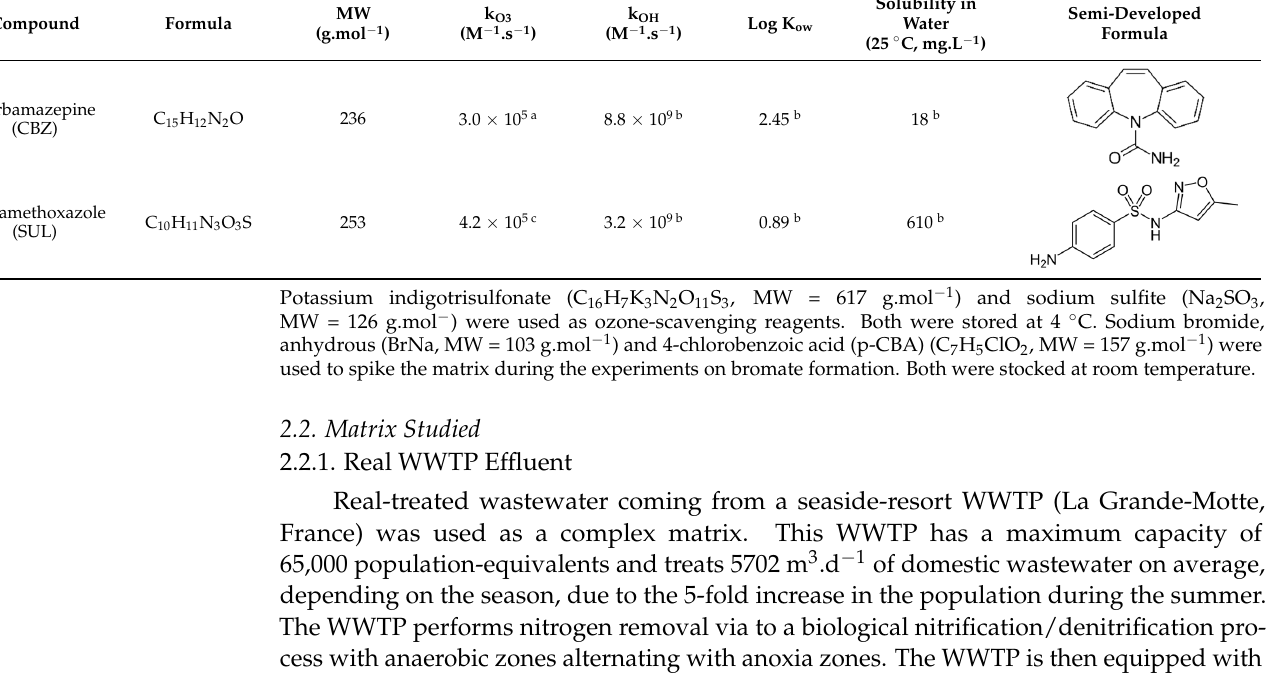
Table 1. Main characteristics of the targeted micropollutants ( a [40], b [41], c [42]). Compound Formula